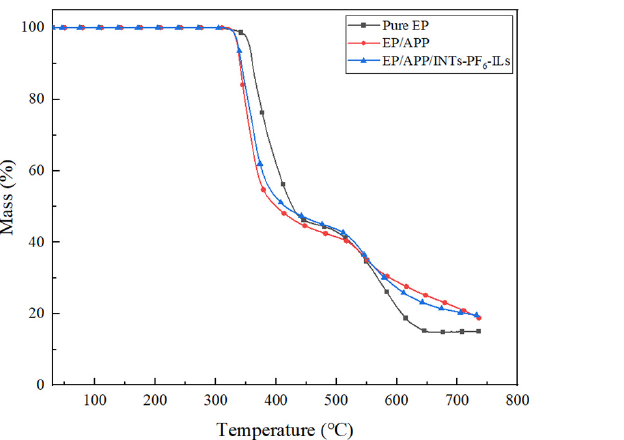
Table 2. LOI and UL-94 rating of EP composites.